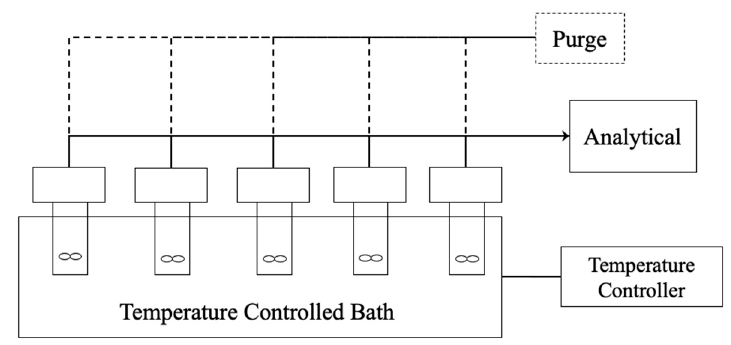
Figure 1. Batch reactors experimental set-up.